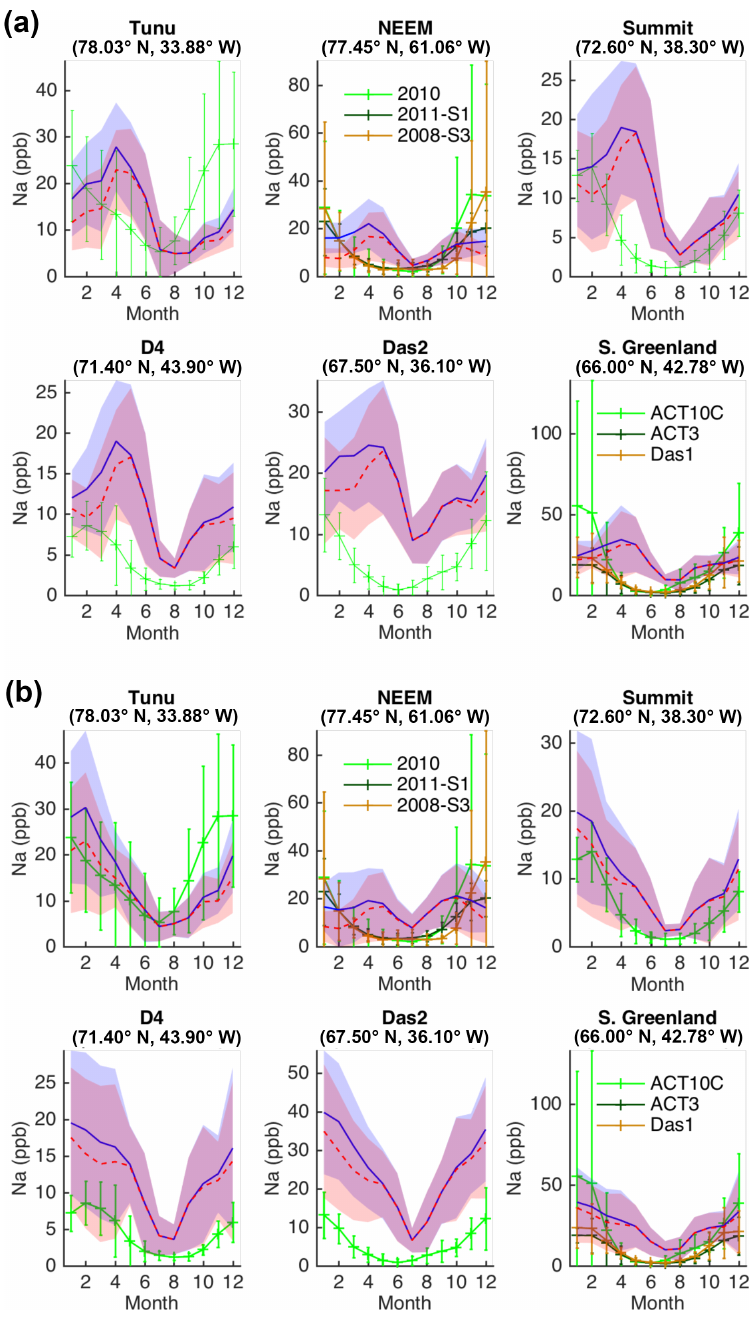
Figure 5. Mean monthly mean sea salt Na concentrations of Greenland ice cores simulated by p-TOMCAT for 1991–1999 compared to data. OOSS simulations (red dashed line) and combined OOSS and SISS simulations (blue line) are shown with uncertainty envelopes (red and blue shading respectively), representing ± 1 σ of the simulated inter-annual variability. Mean monthly ice core Na concentrations (green) are shown with uncertainty bars denoting ± 1 σ of the inter-annual variability. Two sub-plots feature three different ice core records located within the same p-TOMCAT grid box, as indicated by the legend. Two different options for simulated sea salt concentrations are displayed: (a) [Na] calculated using p-TOMCAT precipitation output in Eq. (5) and (b) [Na] calculated using the constant annual accumulation rate indicated by the ice core records (Table 2) in Eq. (5). In both cases, the p-TOMCAT monthly mean time series has been smoothed using a Savitzky–Golay filter (span 4%, order 2) prior to stacking of the monthly mean values for 1991–1999 (Sect.